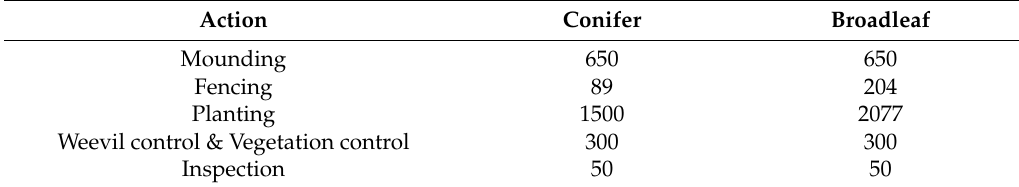
Table A1. Costs ( € ha − 1 ) for individual silviculture actions, based on conifer and broadleaf forests. Source: Coillte.